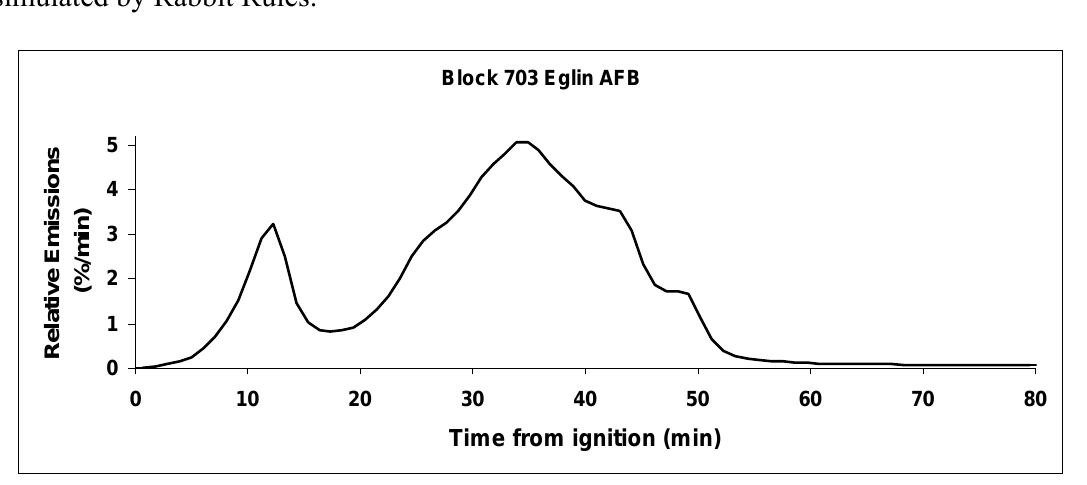
Figure 9. Relative emissions as a function of total emissions for the Block 703C burn as simulated by Rabbit